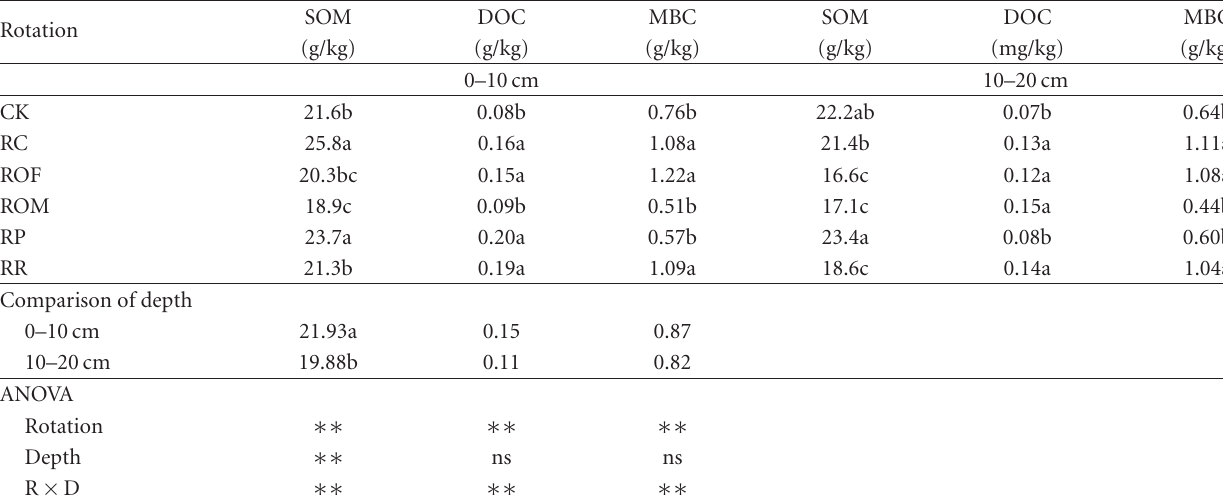
Table 5: Soil organic carbon content, dissolved organic content, and soil microbial organic content in 0–10 and 10–20 cm depth